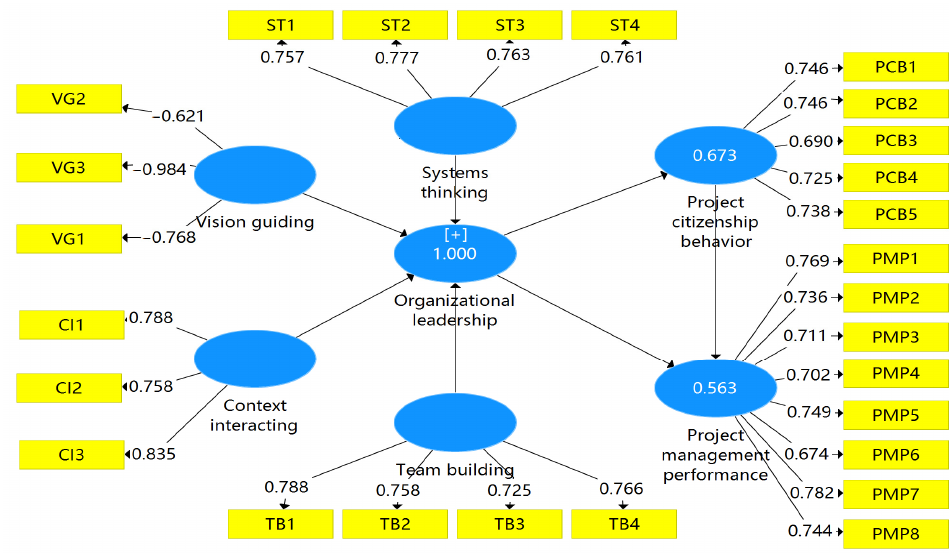
Figure 3. Structural model of OL, PCB, and PMP. Table 9. Summary of the structural model.